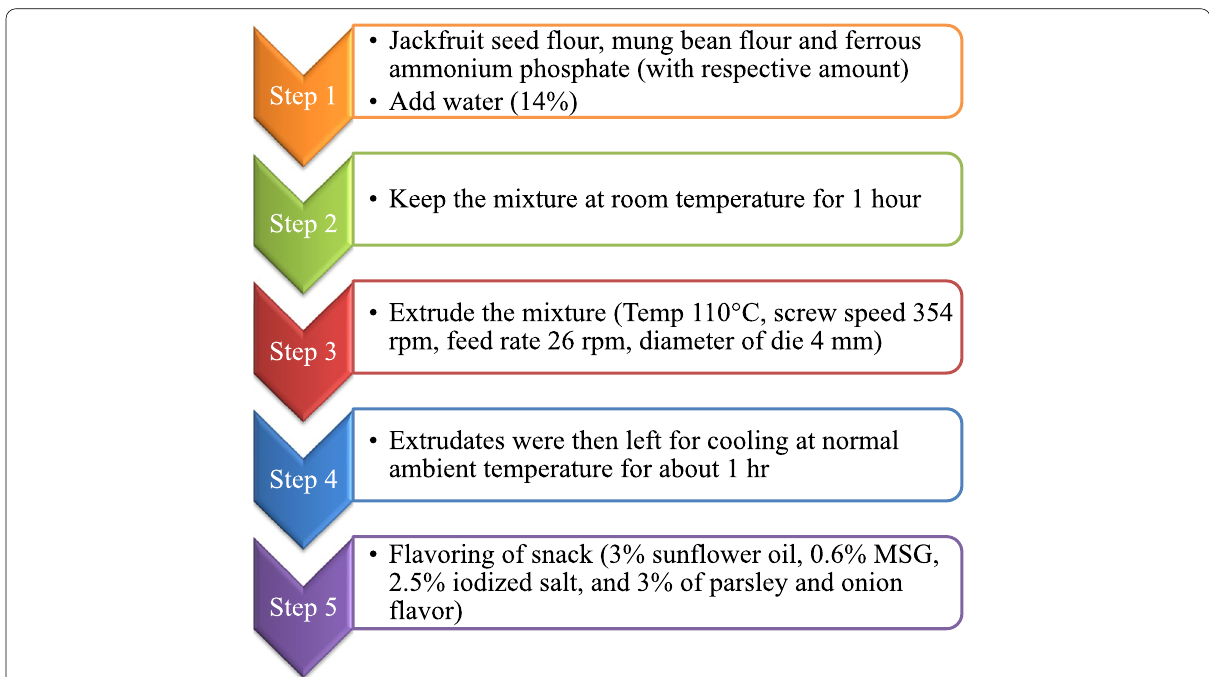
Fig. 1 a Flow diagram of the preparation of the extruded